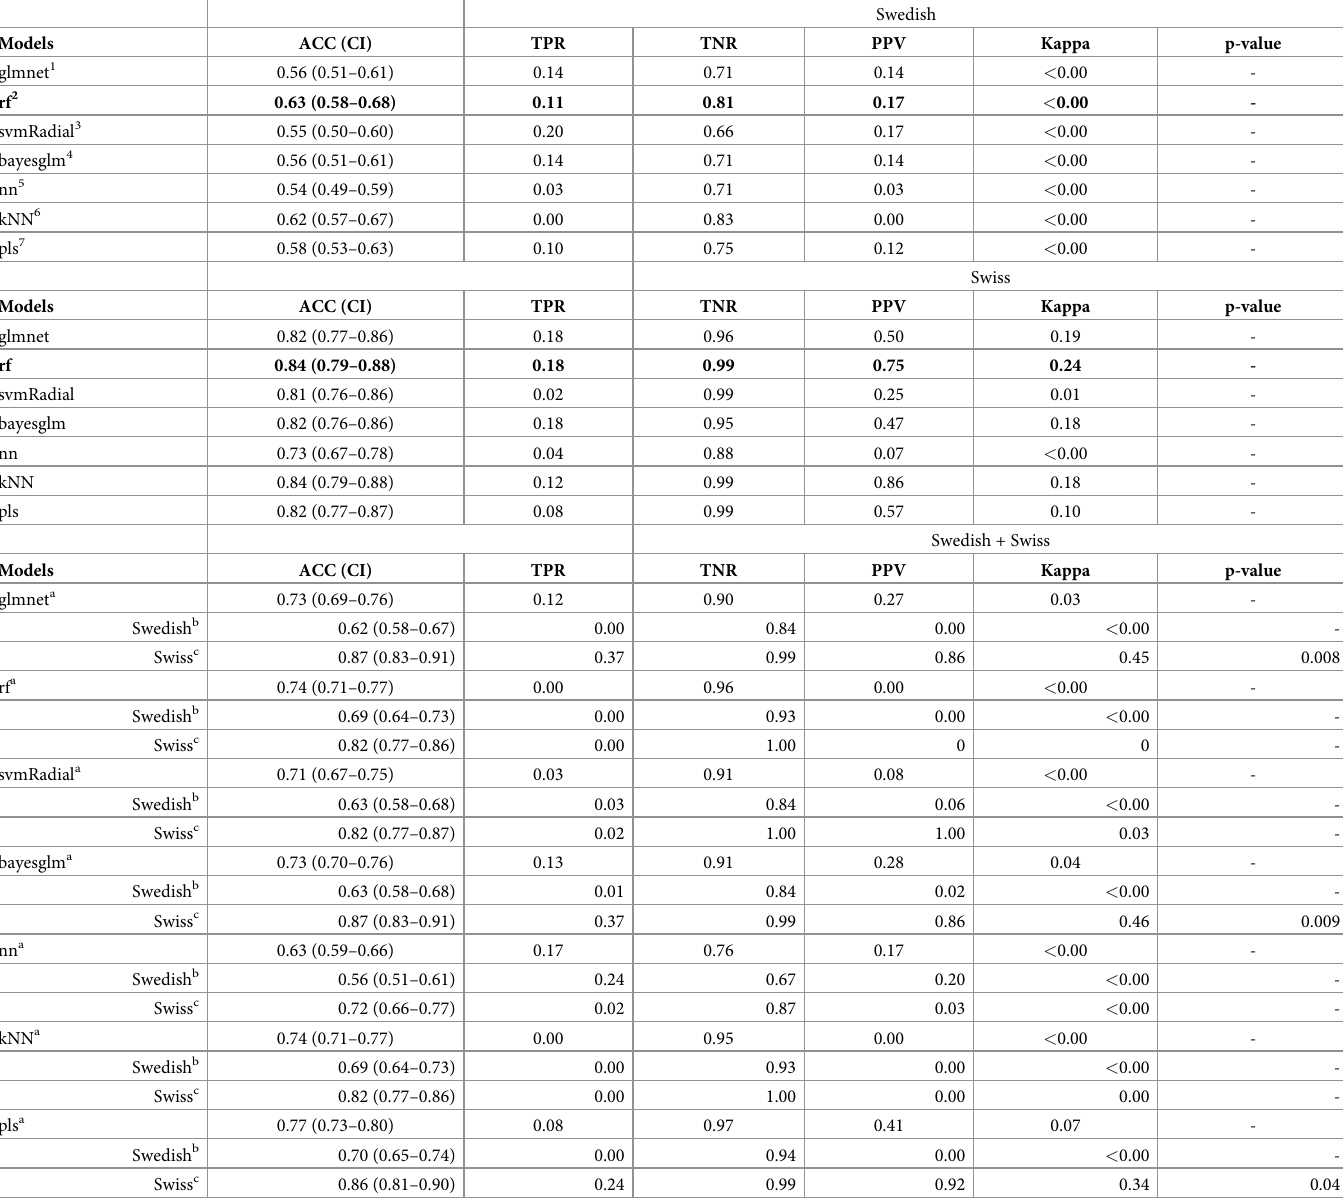
Table 7. Performances of models to predict unseen pens [leave one out cross-validation (LOOP) approach] of the Swedish, Swiss and Swedish+Swiss data